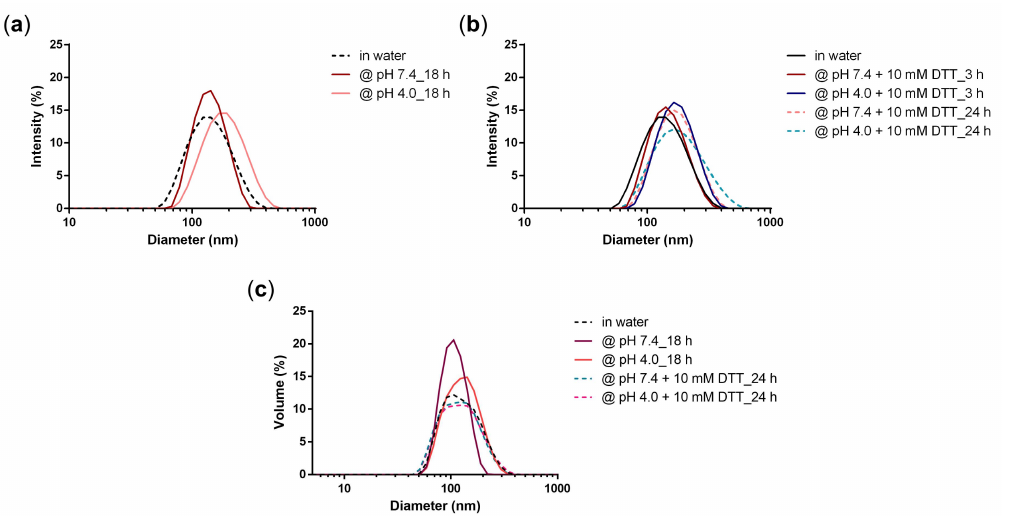
Figure 7. Intensity size distribution of NG3 at ( a ) pH 7.4 and pH 4.0 after 18 h and at ( b ) pH 7.4 and 4.0 in the presence of 10 mM DTT after 3 h and 24 h; ( c ) Volume size distribution of NG3 at pH 7.4 and 4.0 and in the presence of 10 mM DTT after 24